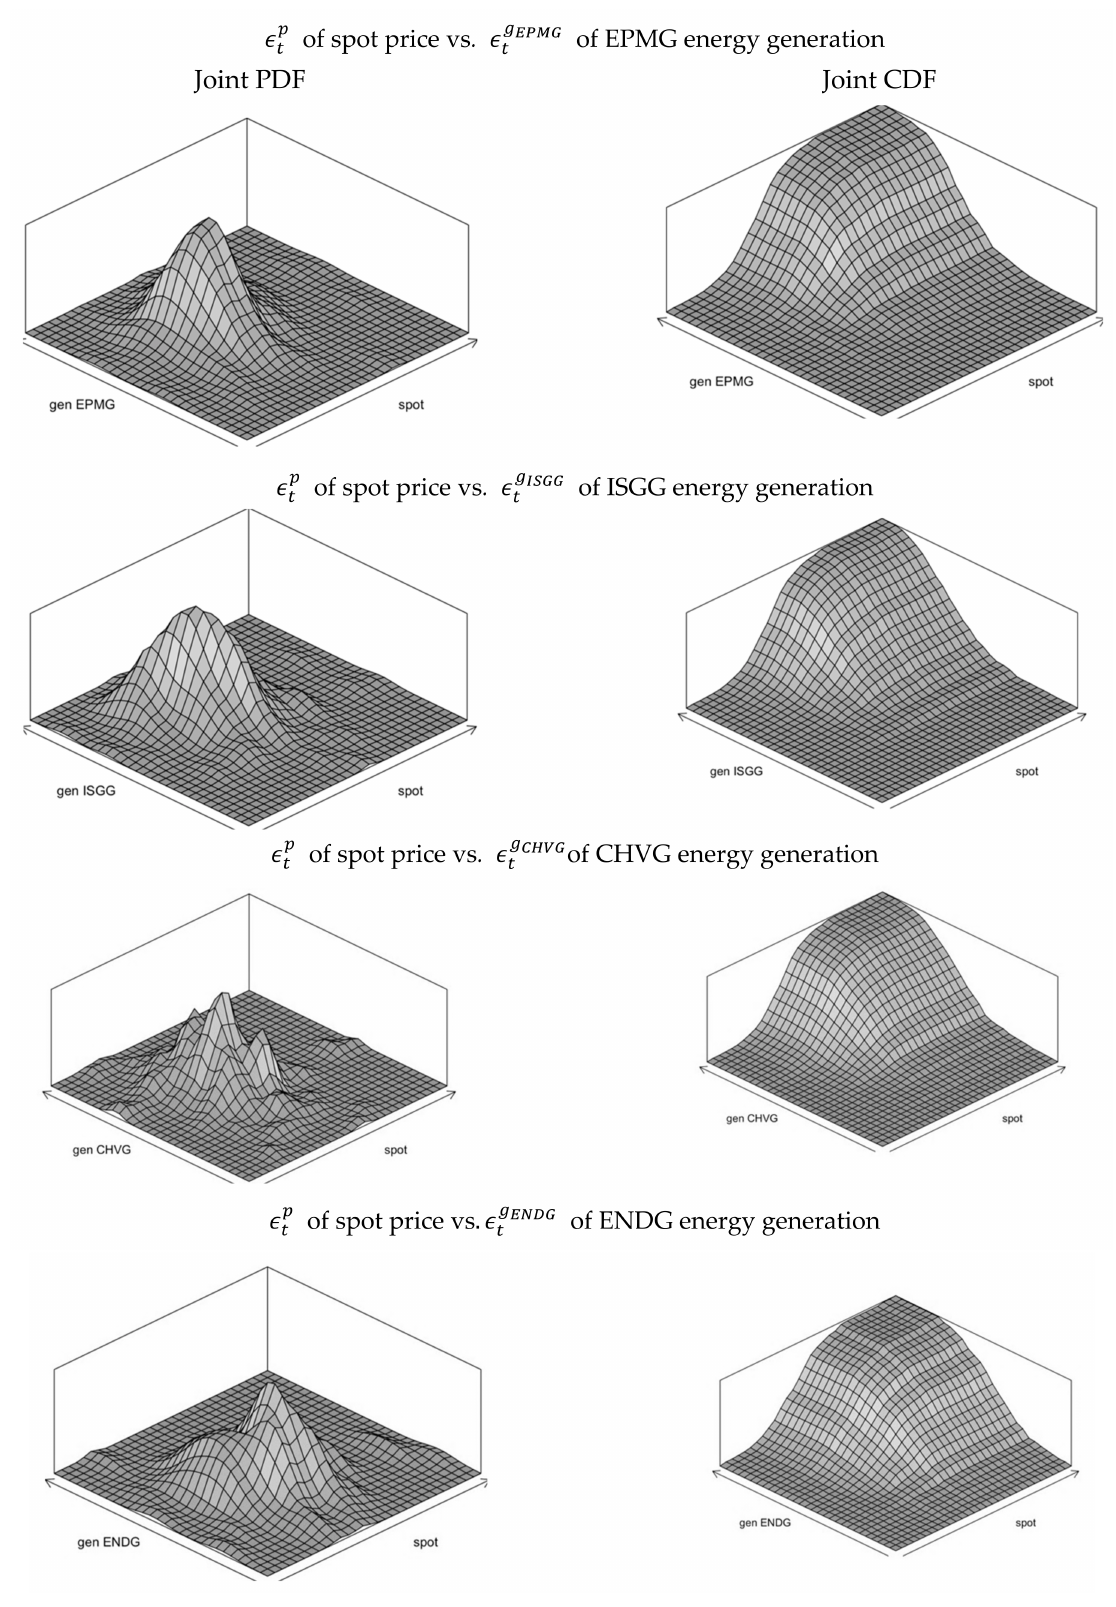
Figure A2. Bivariate PDF and CFF for spot price and energy generation residuals (cid:101) t . Joint probability density (PDF) ( left column) and cumulative distribution (CDF) ( right column) functions for the stochastic